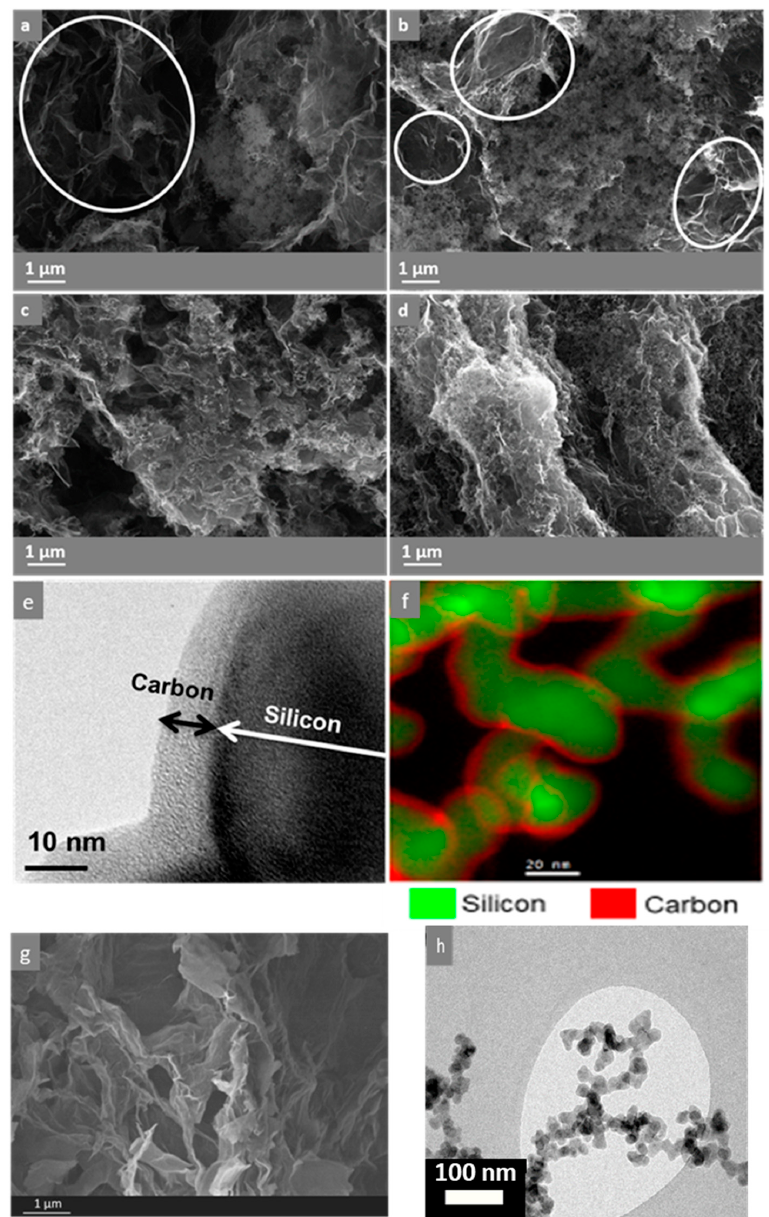
Figure 2 . SEM images of Si-GHG-1h ( a ), Si-GHG-18h ( b ) (with white circles showing areas with low amount of SiNPs), Si@C-GHG-1h ( c ), Si@C-GHG-18h ( d ). TEM image ( e ) and STEM-EELS ( f ) images of Si@C NPs highlight the carbon shell around Si NPs. SEM images of reference GHG sample (not fi lled with Si nor Si@C particles) synthesized in 18 h ( g ). TEM image of Si@C NPs ( h ).